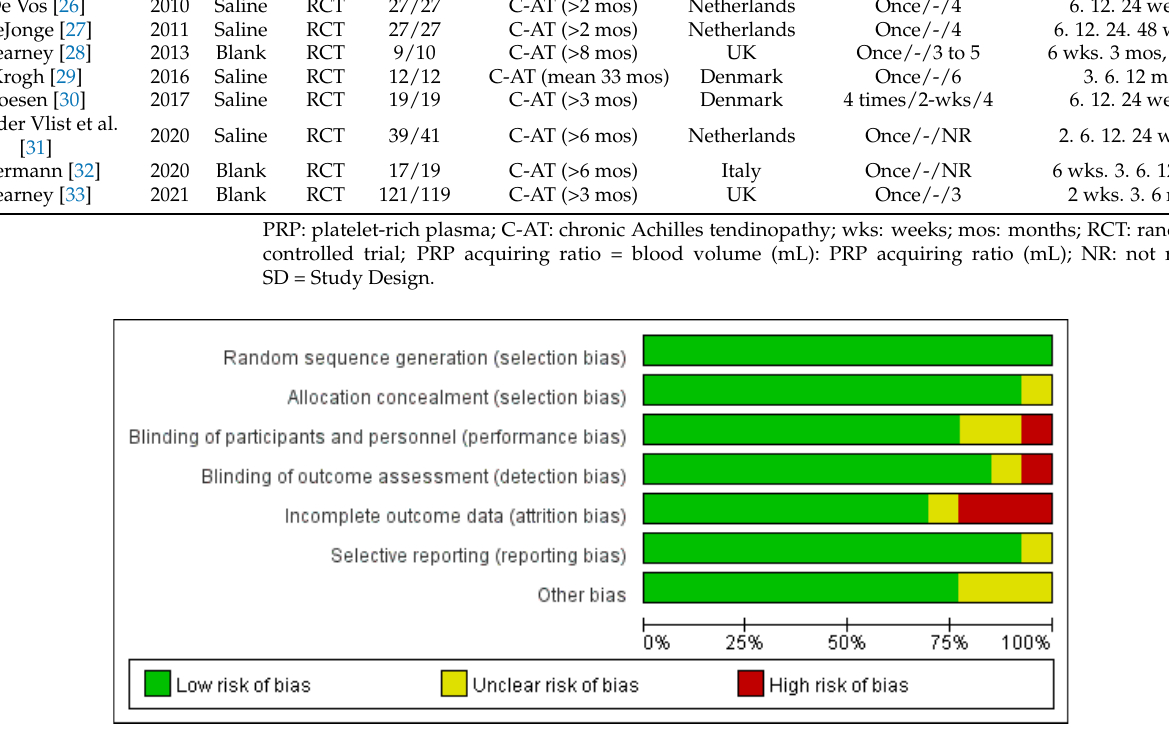
Figure 2. Proportional risk of bias graph: judgement of the percentage of bias items arising from all included studies.